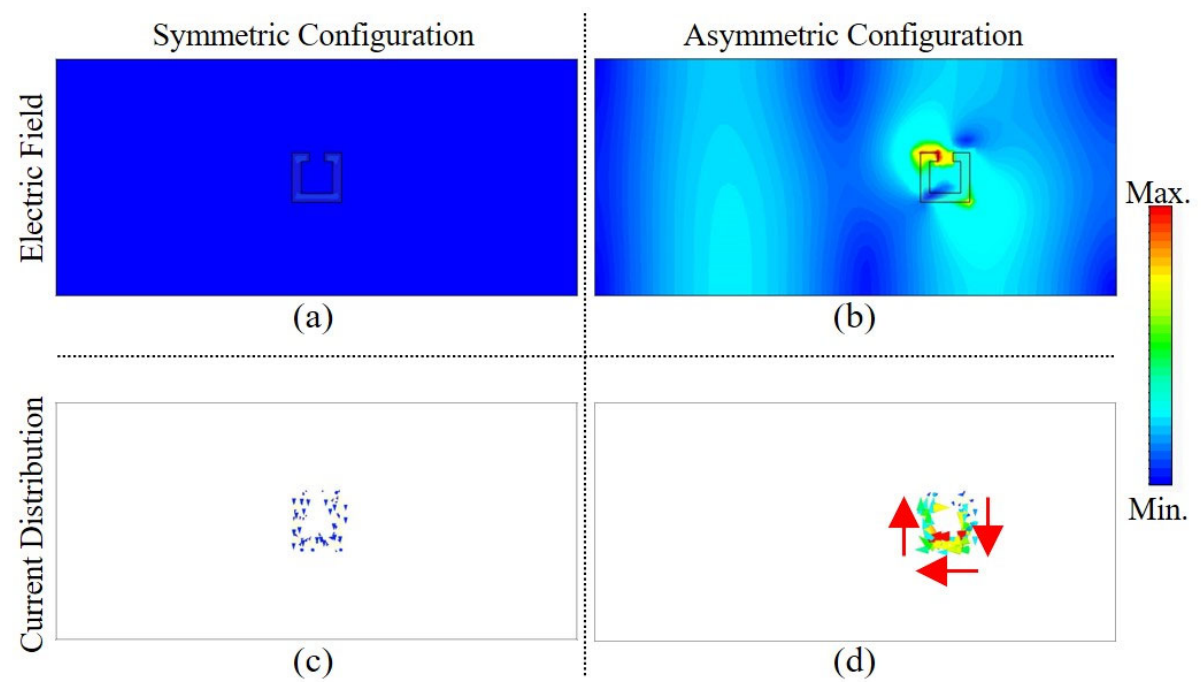
Figure 4. ( a , b ) Spatial electric field distribution at the surface of the designed SRR structures at 6.9 GHz for the symmetric and asymmetric configurations, respectively; ( c , d ) current distribution at 6.9 GHz for the same configurations. The red arrows were added to visualize the direction of the current.